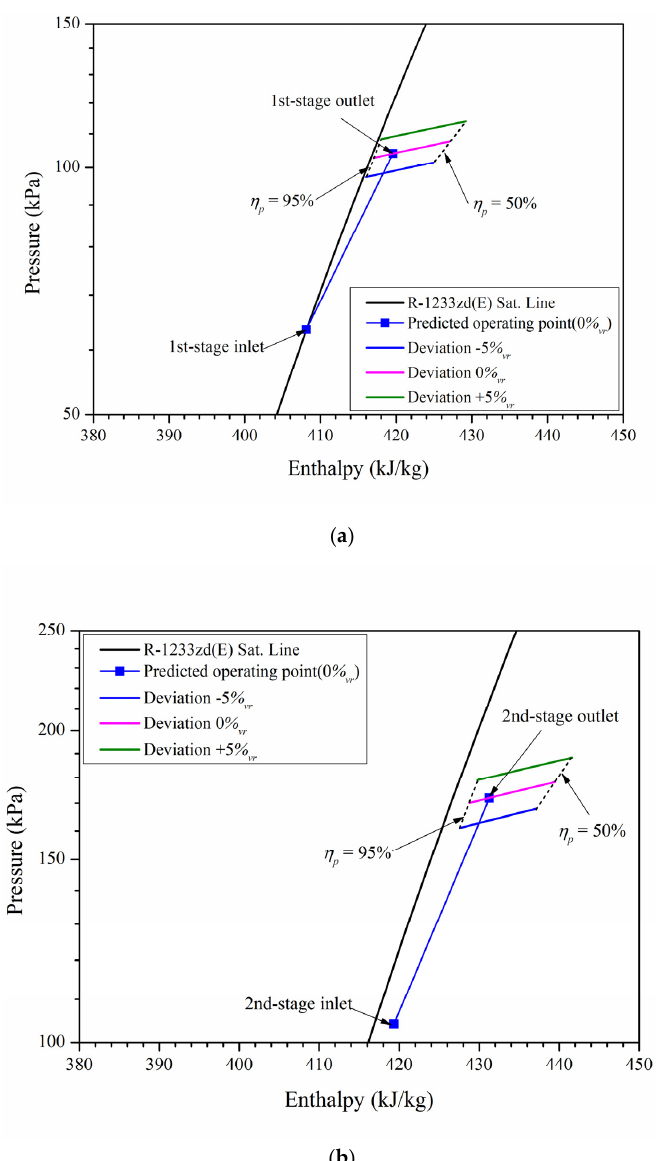
Figure 10. Calculated operating range and operating point for DR-33. ( a ) First stage and ( b ) second stage.